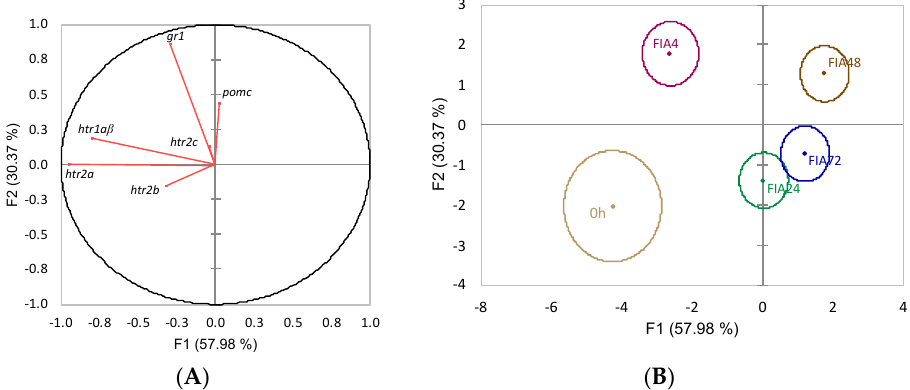
Figure 8. Canonical discriminant analysis of European seabass pituitary gland expression of HPI-axis-related genes. ( A ) Correlation variables/factors (factor loads) for two main discriminant functions (F1 and F2); gr1 , glucocorticoid receptor 1; htr1a β , serotonin receptor 1A β ; htr2a , serotonin receptor 2A; htr2b , serotonin receptor 2B; htr2c , serotonin receptor 2C; pomc , proopiomelanocortin. ( B ) Canonical discriminant scores of each group. Group centroids are marked by a small diamond, whereas circles indicate data distribution per